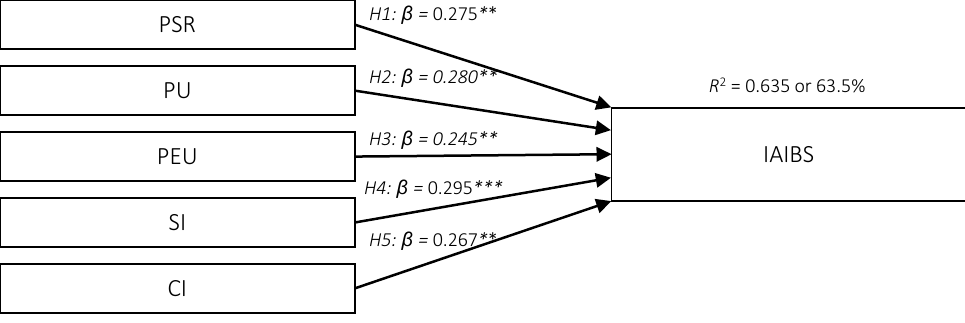
Figure 2. Regression analysis